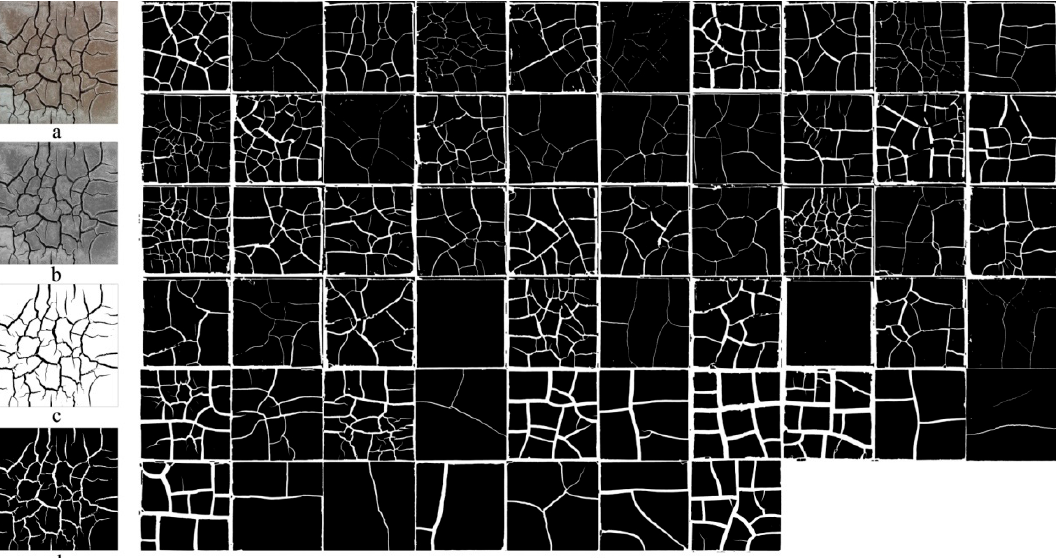
Figure 3. Cracked soil surface image processing and final results of 57 soil samples. ( a ) Geometrically corrected and tailored crack images, ( b ) transformed gray crack image, ( c ) transformed binary crack image, ( d ) inversed binary crack image, ( e ) crack images of all samples after denoising process.